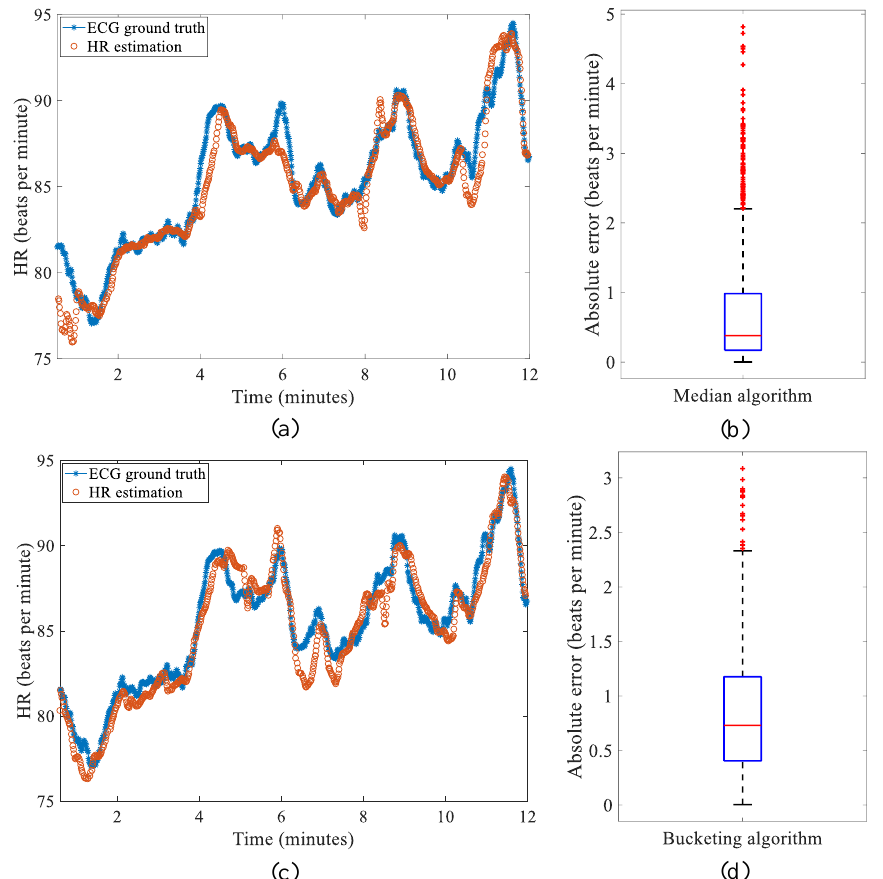
Figure 11. Results from the median-value-based algorithm and bucketing algorithm for HR estimation. ( a ) HR estimation compared with ECG ground-truth—median algorithm and ( b ) absolute error box plot. ( c ) HR estimation compared with ECG ground-truth—bucketing algorithm and ( d ) absolute error box